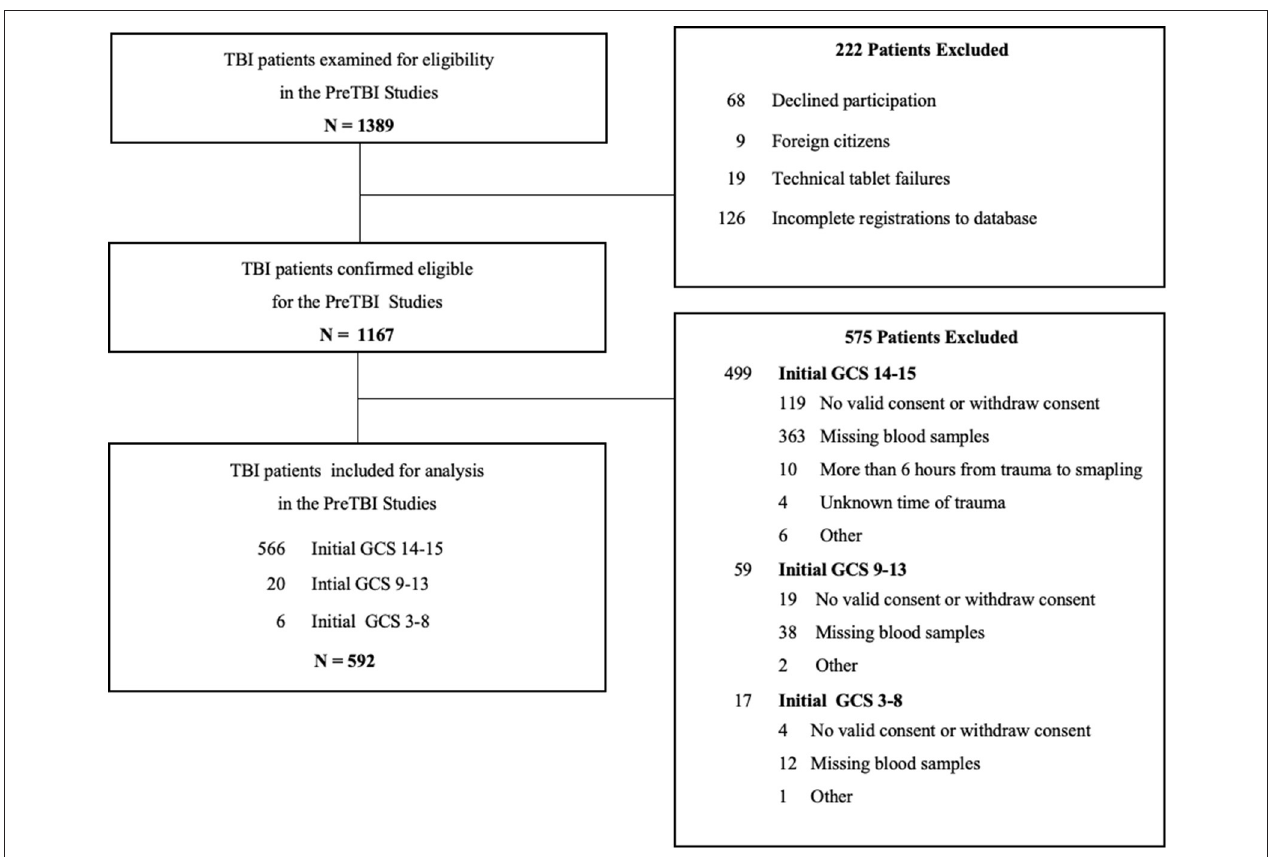
FIGURE 1 | Flow diagram of patient inclusion and exclusion in the PreTBI